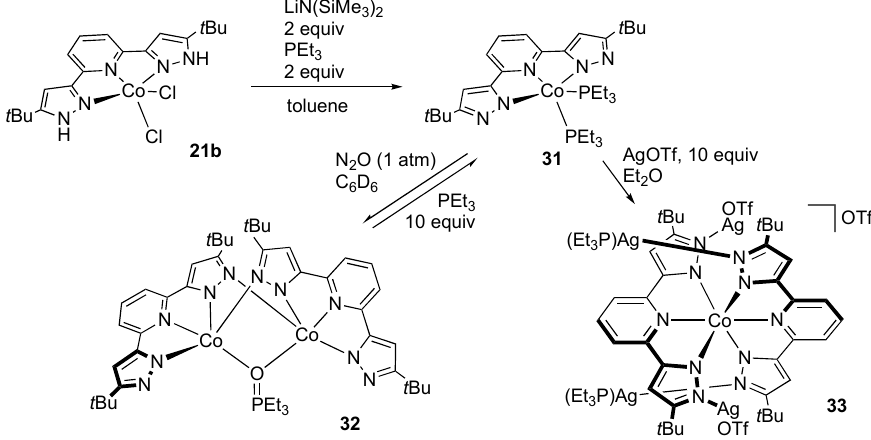
Molecules 2023 , 28 , x FOR PEER Scheme 10. Dehydrochlorination and subsequent reactions of the t Bu LH 2 cobalt complex 21b .